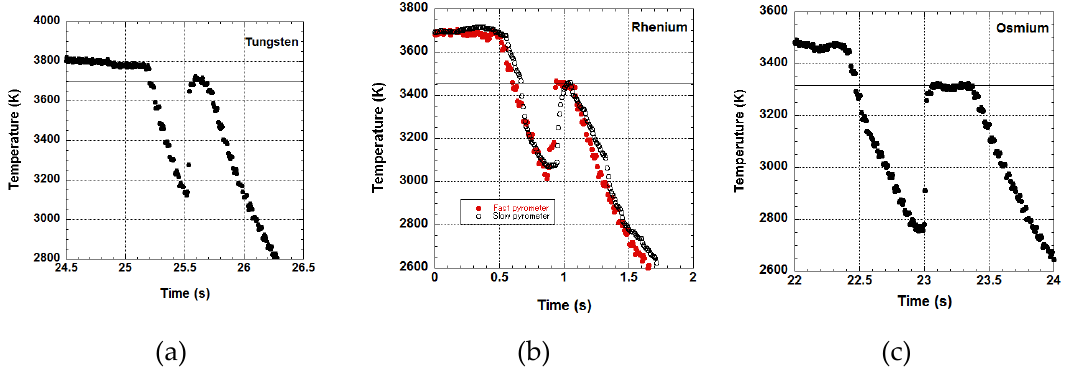
Figure 8. Temperature history of melted and radiatively cooled samples samples showing supercooling and recalescence; ( a ) W, ( b ) Re, and ( c ) Os. In the case of Re, the temperature data obtained with a slow pyrometer are also